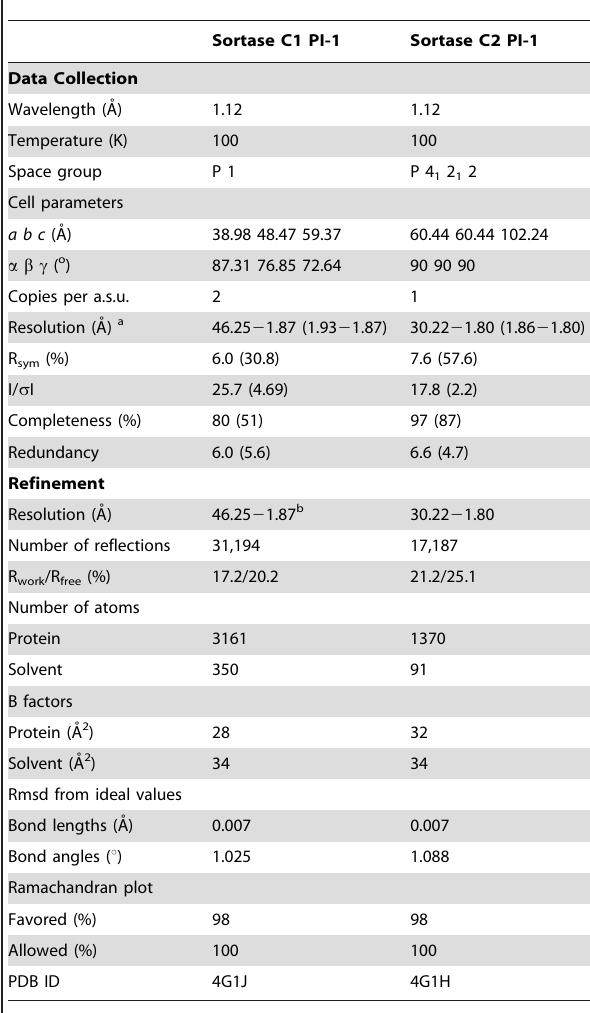
Table 1. Data Collection and Refinement